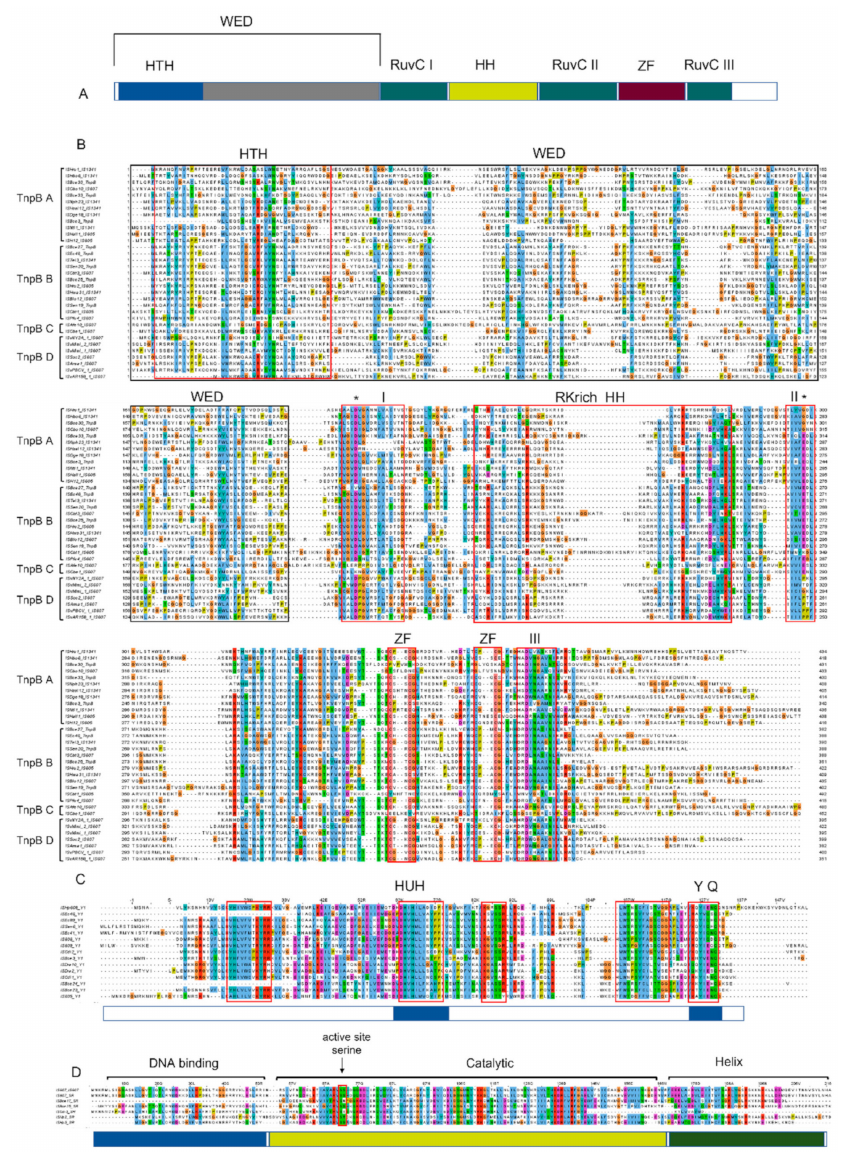
Figure 4. The alignments of TnpB, Y1, and SR protein sequences. The alignment was performed with MAFFT and drawn by Jalview Version 2. ( A ) Schematic of TnpB. The key domains include HTH—helix turn helix (blue), WED—wedge domain (grey), RuvC I, II, III (green), HH—arginine rich helix (yellow), ZF—zinc finger (red). ( B ) The alignment of several sequences was selected from TnpB-B, TnpB-B, TnpB-C and TnpB-D subgroups according to the phylogenetic tree. The HTH, RKrich HH, ZF, and RuvC I, II, and III domains are marked using a red box. ( C ) The alignments of the Y1 sequence. The HuH, Y and Q residues are indicated. ( D ) The alignments of SR. The DNA banding, catalytic, and Helix domains are also shown. The active site seine is marked using a black